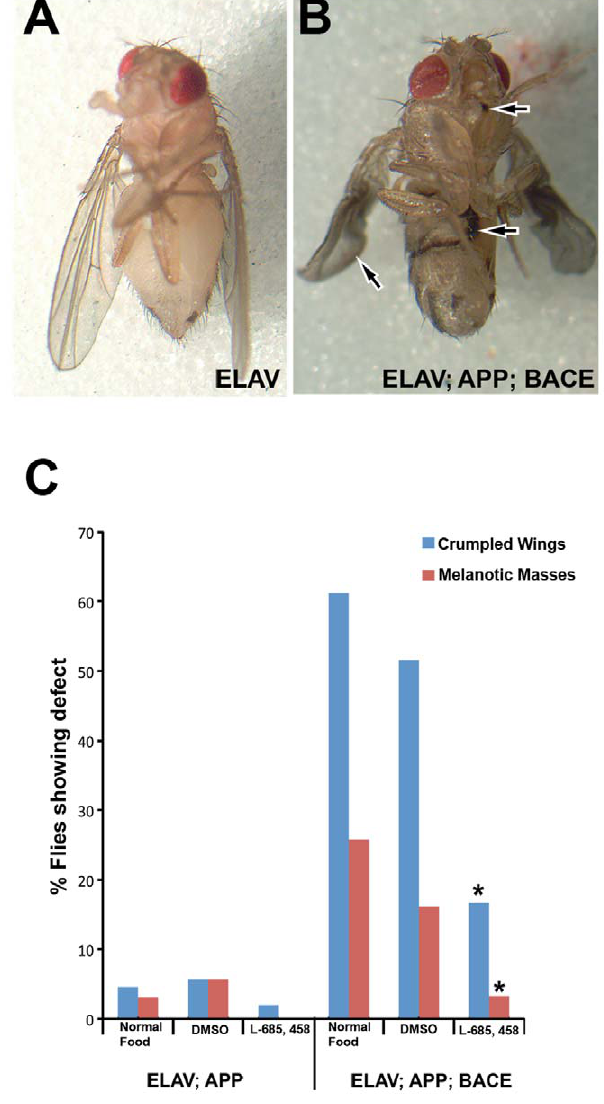
Figure 2. External morphology and longevity in AD flies. A ) elav ; + ; + heterozygous fly one day after eclosion showing no defects on ventral proboscis, ventral abdomen, or in wings. B ) Arrows indicate regions of the elav ; APP ; BACE heterozygous fly one day after eclosion showing melanotic masses on ventral proboscis, ventral abdomen, and curled wings. C ) Quantification of the external defects shown in (B). n . 50 in each case. Genotypes and treatments indicated. * indicates p , .001 between DMSO and L-685,458.